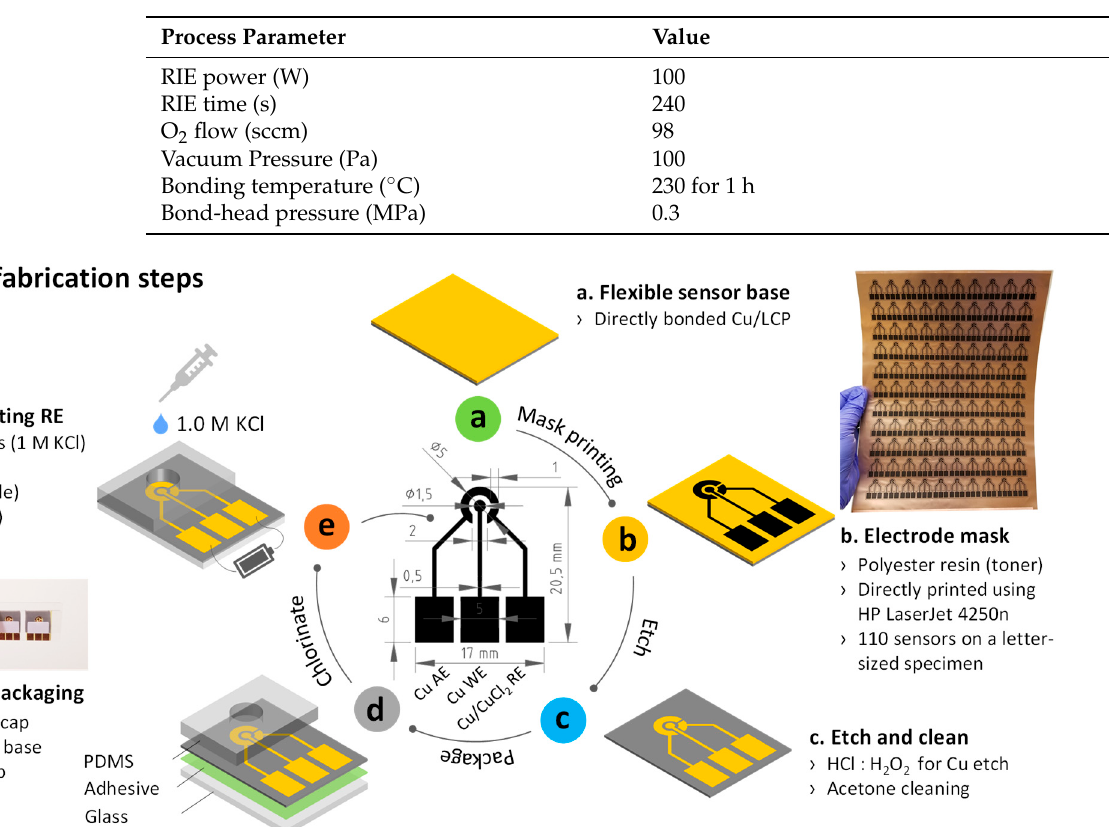
Table 1. Surface activated bonding (SAB) parameters for directly bonded electrodes.